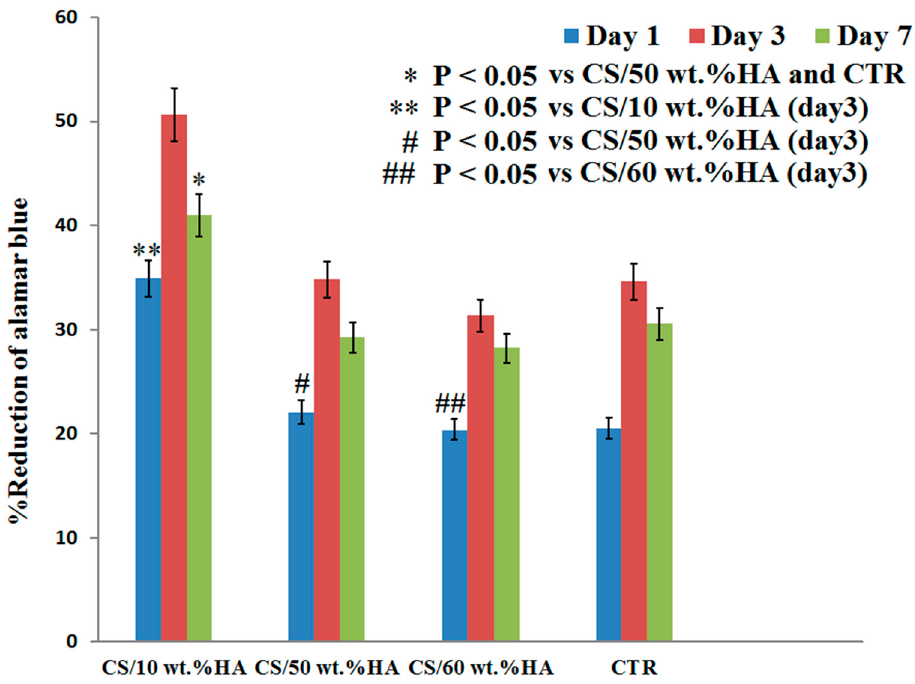
Figure 6. Alamar blue assay after 1, 3 and 7 days of cell culture. Data were normalized and compared (mean, SD, n = 3) using a one-way ANOVA, P < 0.05.